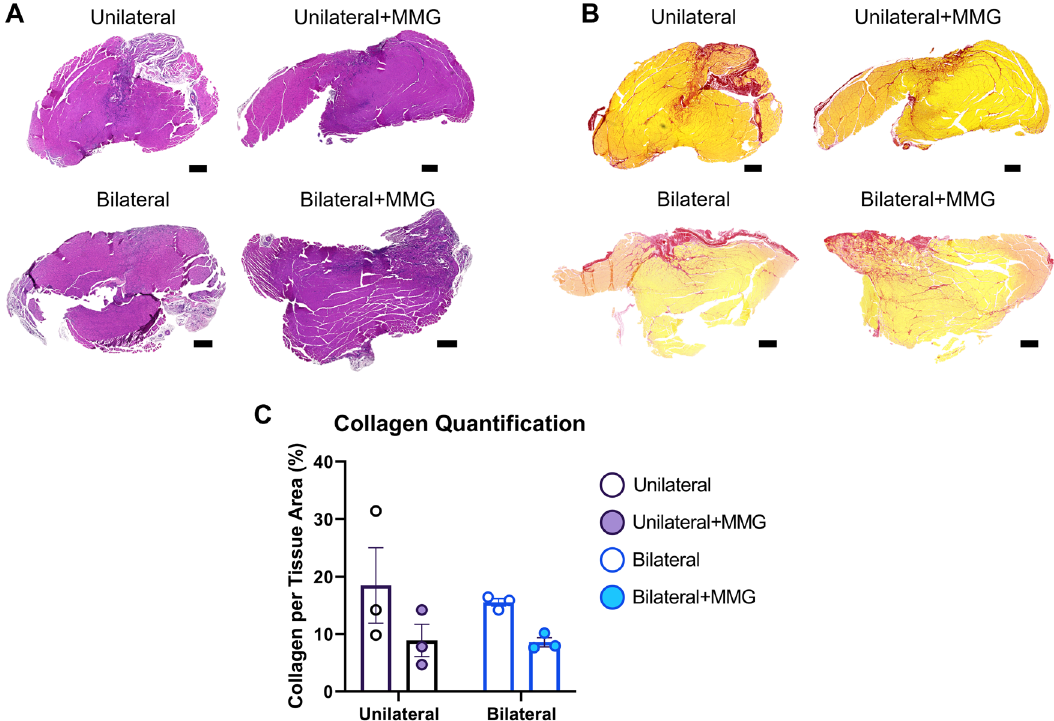
Fig. 5 Histological analysis of unilateral and bilateral injured TA muscles. Histology of TA muscles at 8 week post-VML injury with A hematoxylin and eosin and B picrosirius red staining. Scale bars = 500 µm. C Quanti fi cation of collagen deposition in VML injured TA